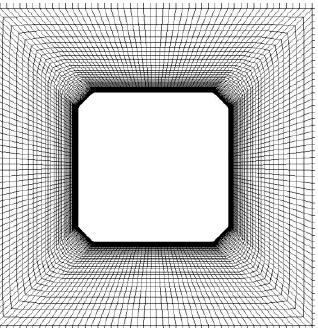
Figure 1. The size of calculation domain.